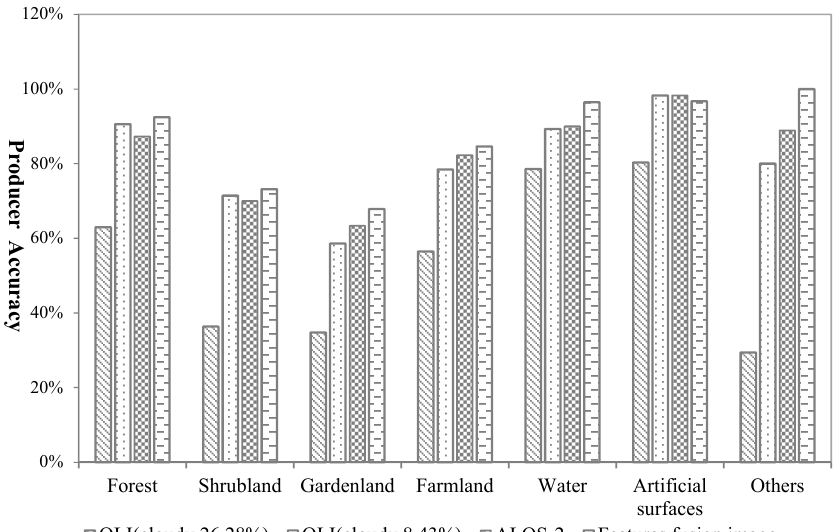
Figure 17. Comparison of producer accuracy (PA) of various land-cover types.